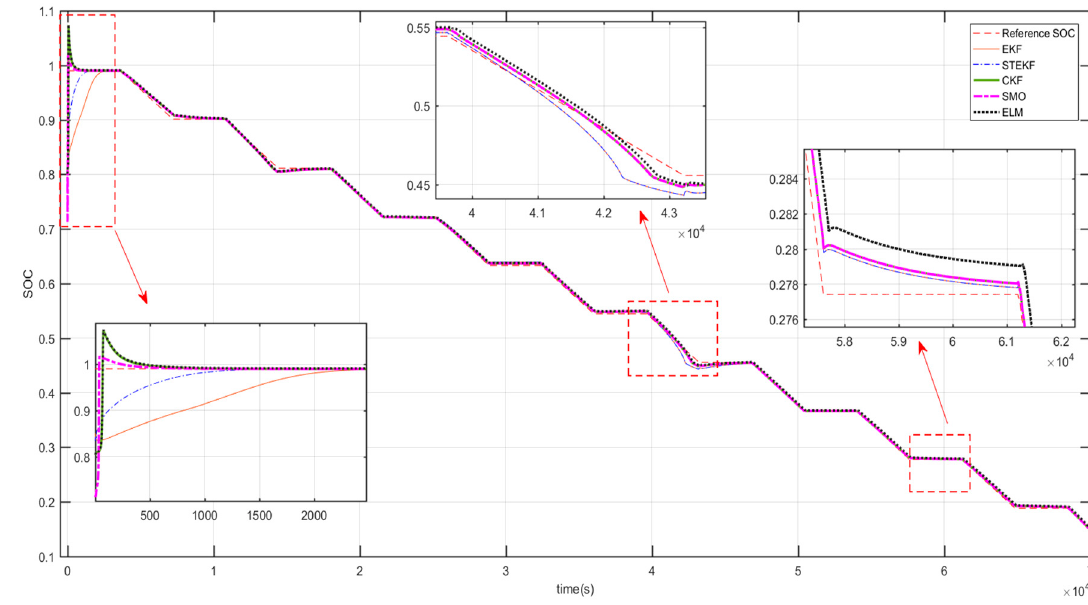
Figure 10. SOC estimation using EKF-based approaches and ELM. Table 7. Comparing SOC estimation performance using EKF-based approaches and ELM.